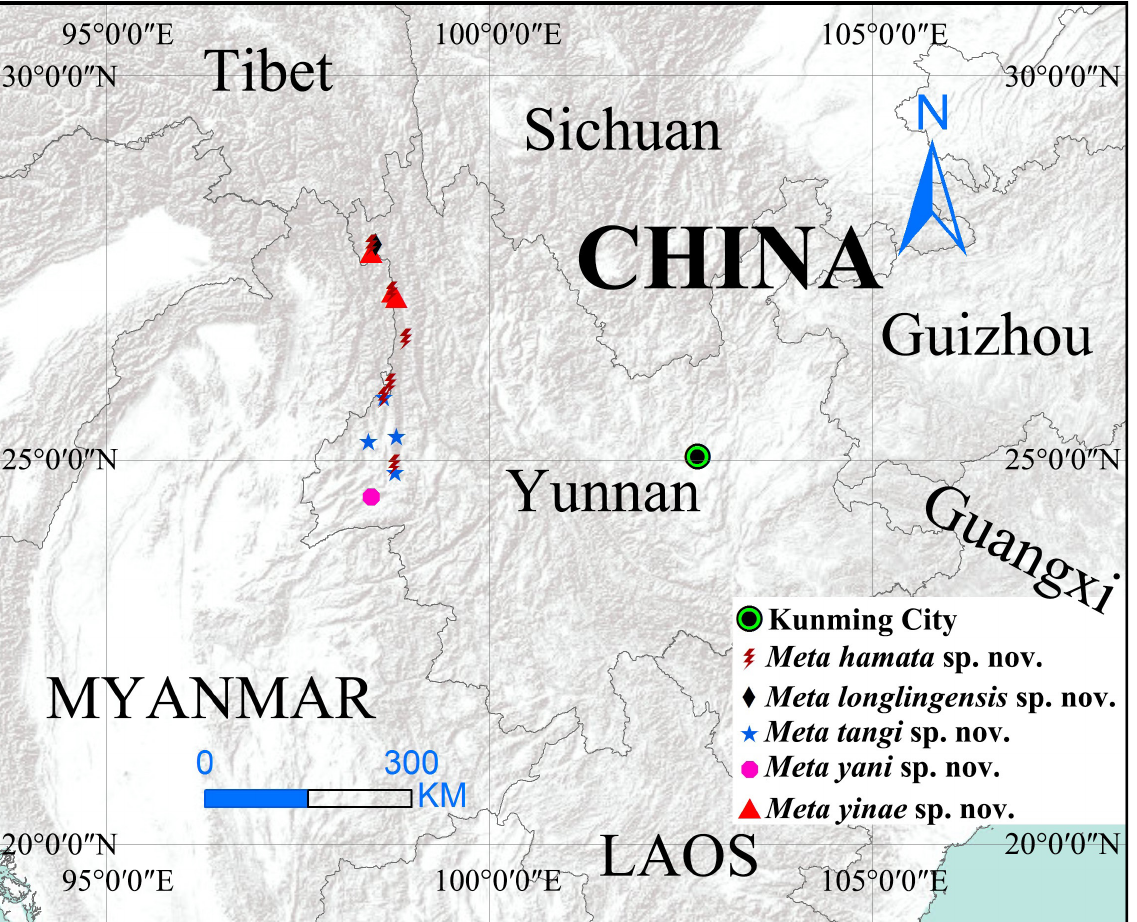
Fig. 16. Distribution records of five new species of the genus Meta Koch, 1836 in Gaoligong Mountains, Yunnan,